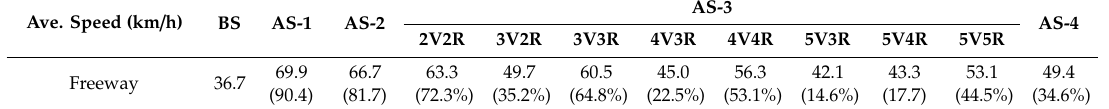
Table 6. Average queue length results of each scenario.